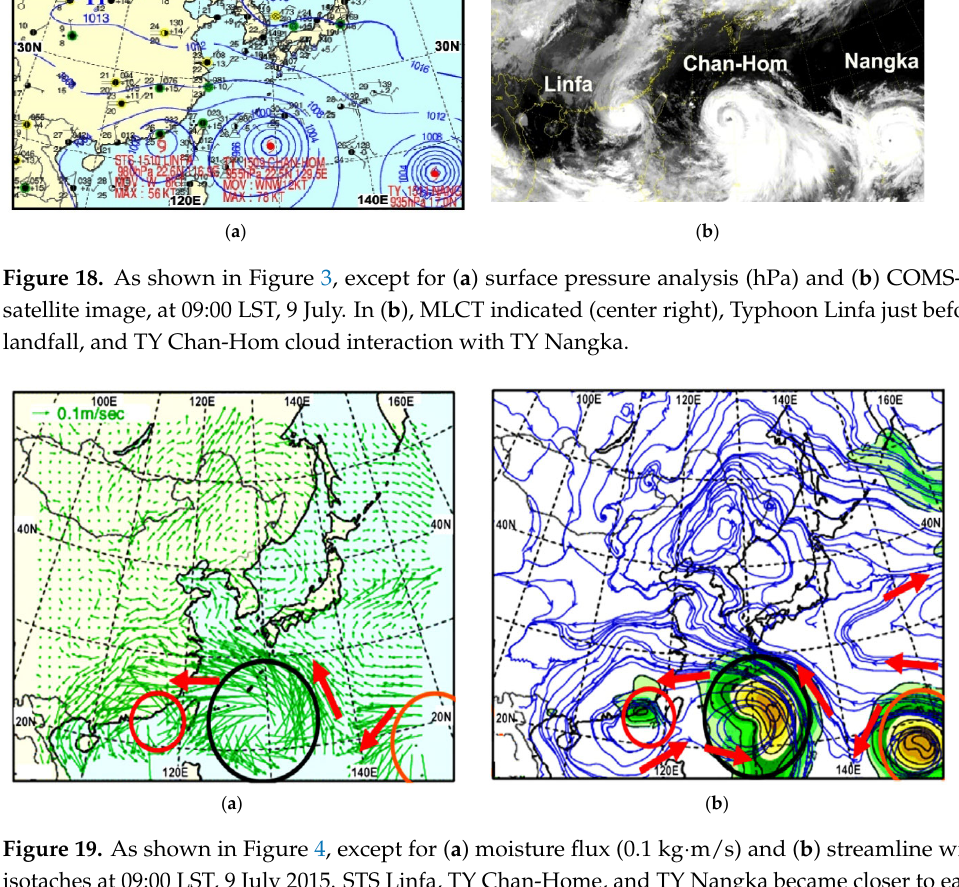
Figure 19. As shown in Figure 4, except for ( a ) moisture flux (0.1 kg · m/s) and ( b ) streamline with isotaches at 09:00 LST, 9 July 2015. STS Linfa, TY Chan-Home, and TY Nangka became closer to each other as a result of multiple interactions among them.